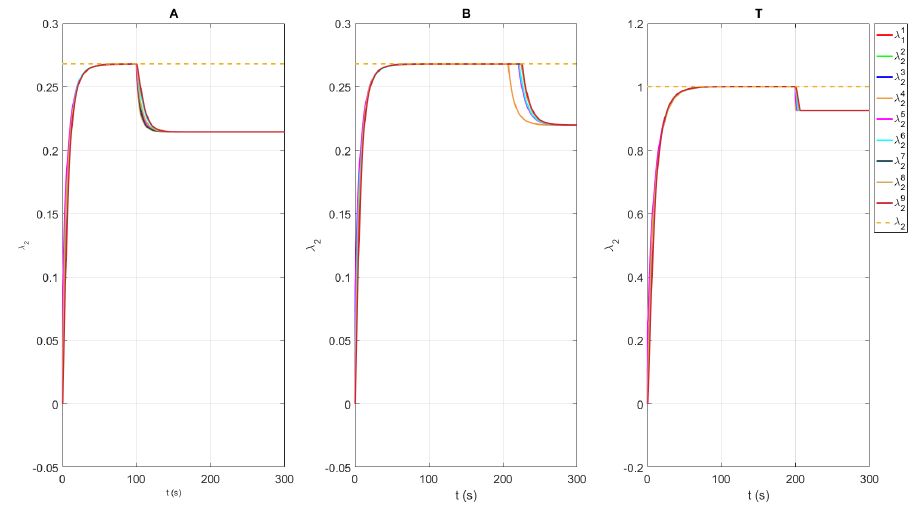
Figure 7. The responses for estimated algebraic connectivity for graph topologies defined with channels A, B, and T. Dashed line represents maximal value of the algebraic connectivity obtained in the case when all links in the considered graph’s topology